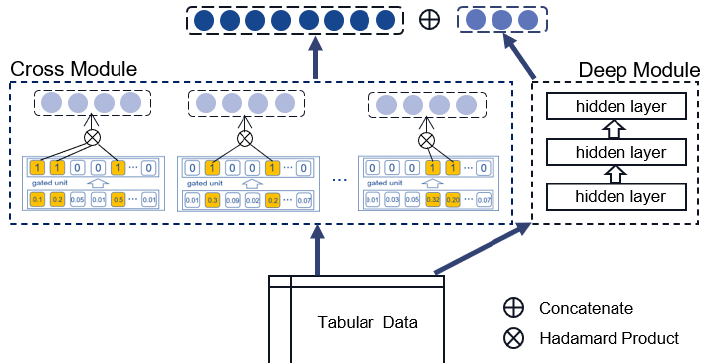
Figure 2. Structure of GAIN. The cross-module is composed of multiple interaction units, each of which can learn a high-order feature interaction using Hadamard product. The output of all units is concatenated with the output of the deep module to obtain the final output of the